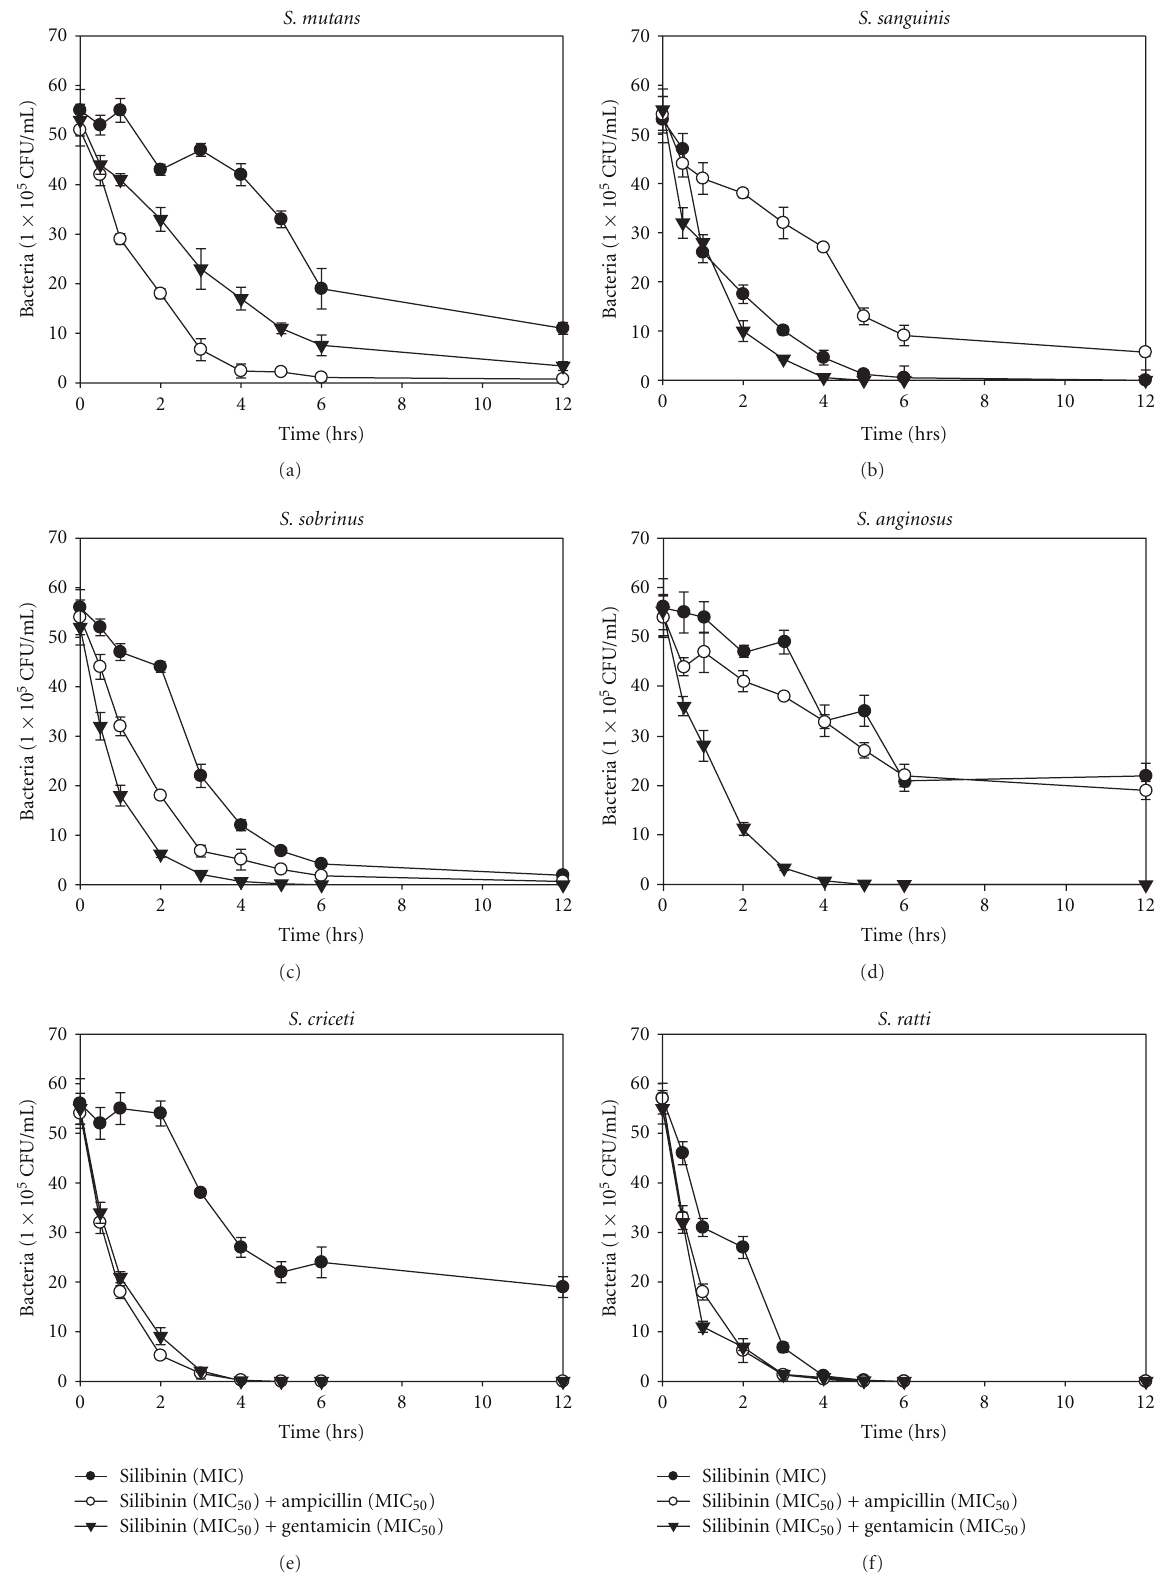
Figure 1: Time-kill curves of MIC of silibinin alone and its combination with MIC 50 of ampicillin or gentamicin against S. mutans , S. sanguinis , S. sobrinus , S. anginosus , S. criceti , and S. ratti . Bacteria were incubated with silibinin ( • ), silibinin + ampicillin ( ◦ ), and silibinin + gentamicin ( (cid:2) ) over time. Data points are the mean values ± S.E.M. of six experiments. CFU: colony-forming